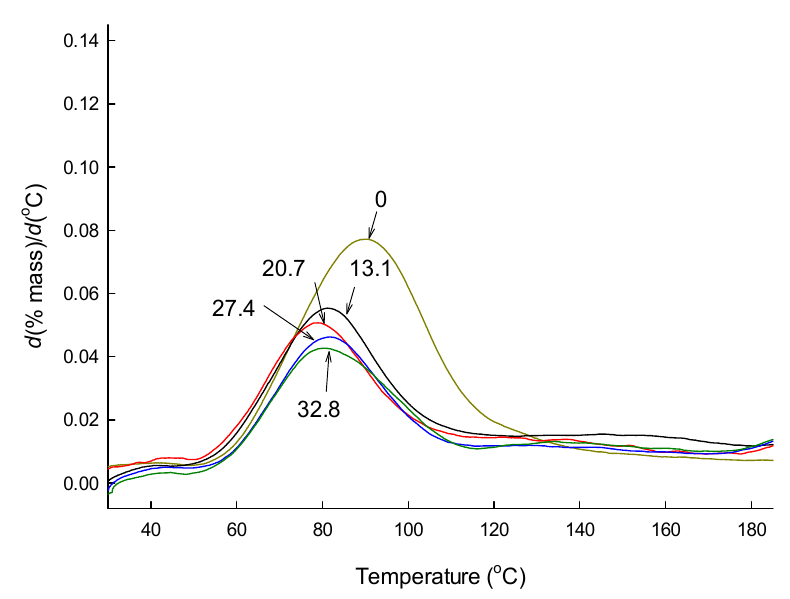
Figure 5. DTG curves of PLGA microspheres containing various amounts of progesterone. Numbers indicate actual progesterone payloads of different PLGA microspheres.